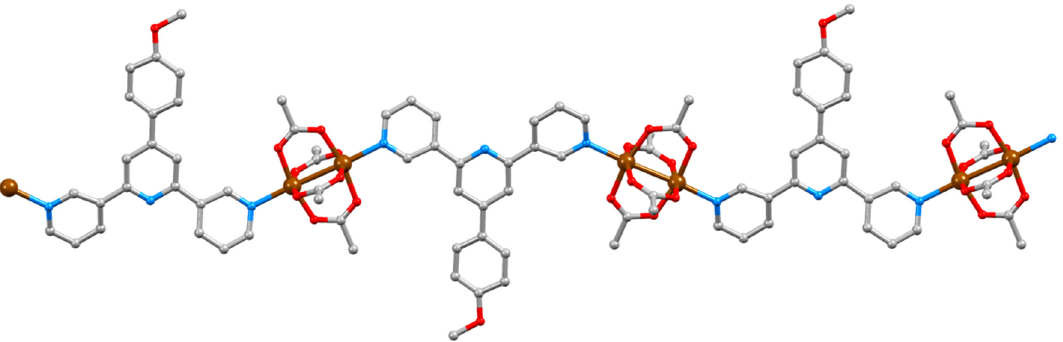
Figure 5. Part of one chain in [Cu 2 ( μ -OAc) 4 ( 1 )] n .